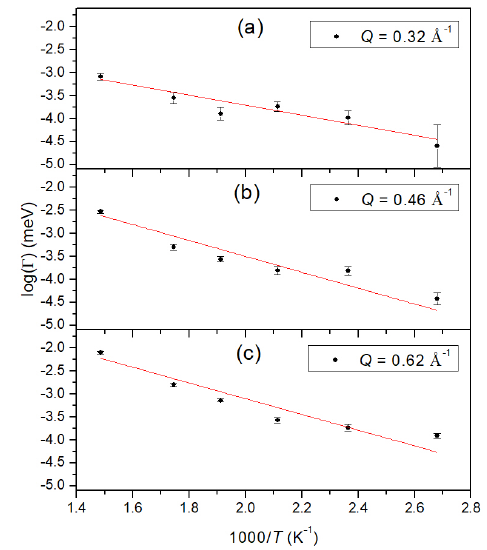
Figure 6. Measured full-width-at-half-maximum (black circles with error bars) plotted against the inverse temperature in an Arrhenius plot for the three smallest Q values. Red line is a fit through all data points. (a) data for Q = 0.32 Å − 1 ; (b) data for Q =0.46 Å − 1 ; (c) data for Q =0.62 Å − 1 .